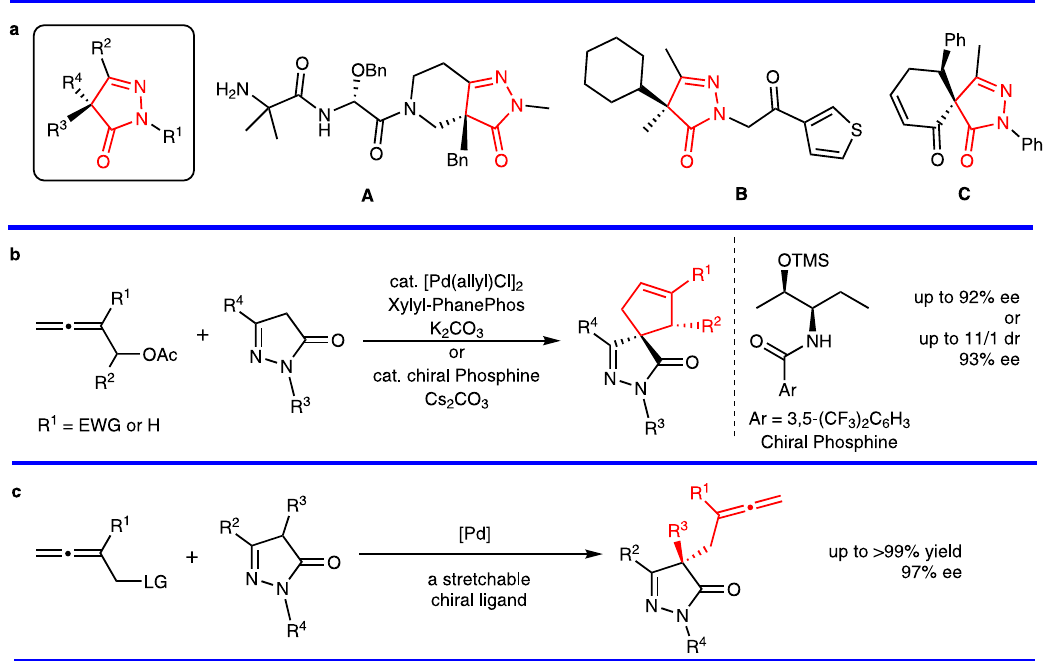
Fig. 1 Background and stretchable ligands for asymmetric allenylation of pyrazolones. a Selected examples of biologically active pyrazolones with a chiral center. b Asymmetric spirocyclization of pyrazolones with 2,3-allenyl acetates. c Stretchable chiral pocket for asymmetric allenylation. EWG electron-withdrawing group, TMS trimethylsilyl, LG leaving